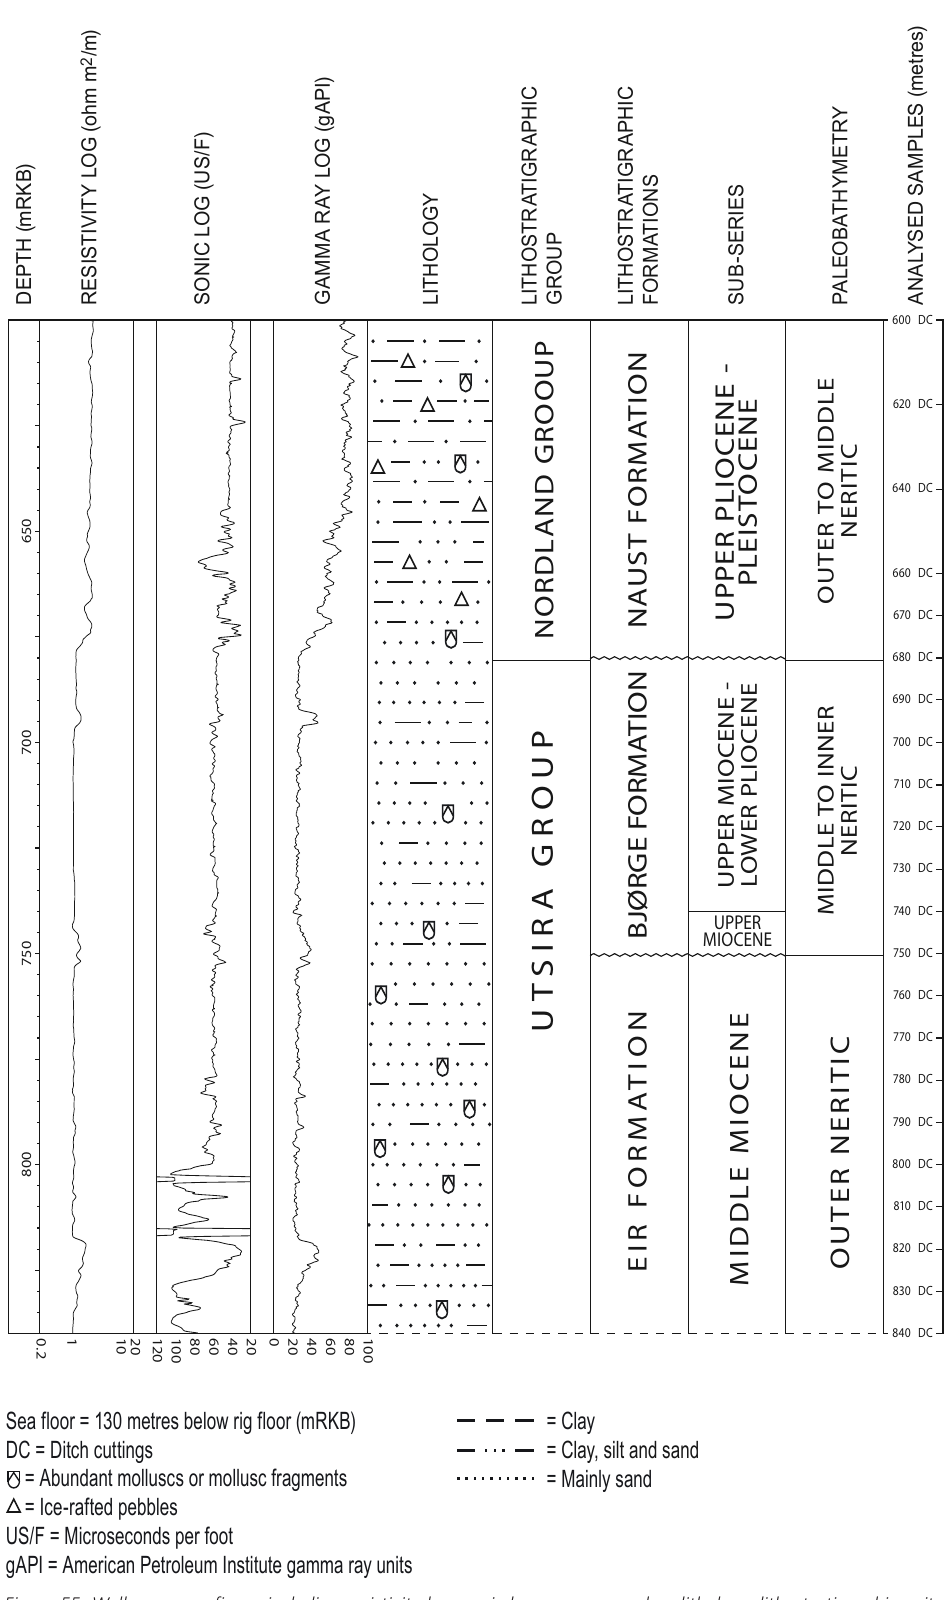
Figure 55. Well summary figure including resistivity log, sonic log, gamma-ray log, lithology, lithostratigraphic units, sub-series, paleobathymetry and analysed samples for the upper part of the investigated sequence in well 30/6–3 (middle Miocene to upper Pliocene–Pleistocene) including the well reference section for the Bjørge Formation (former northern part of the Utsira Formation; modified after Eidvin et al.,